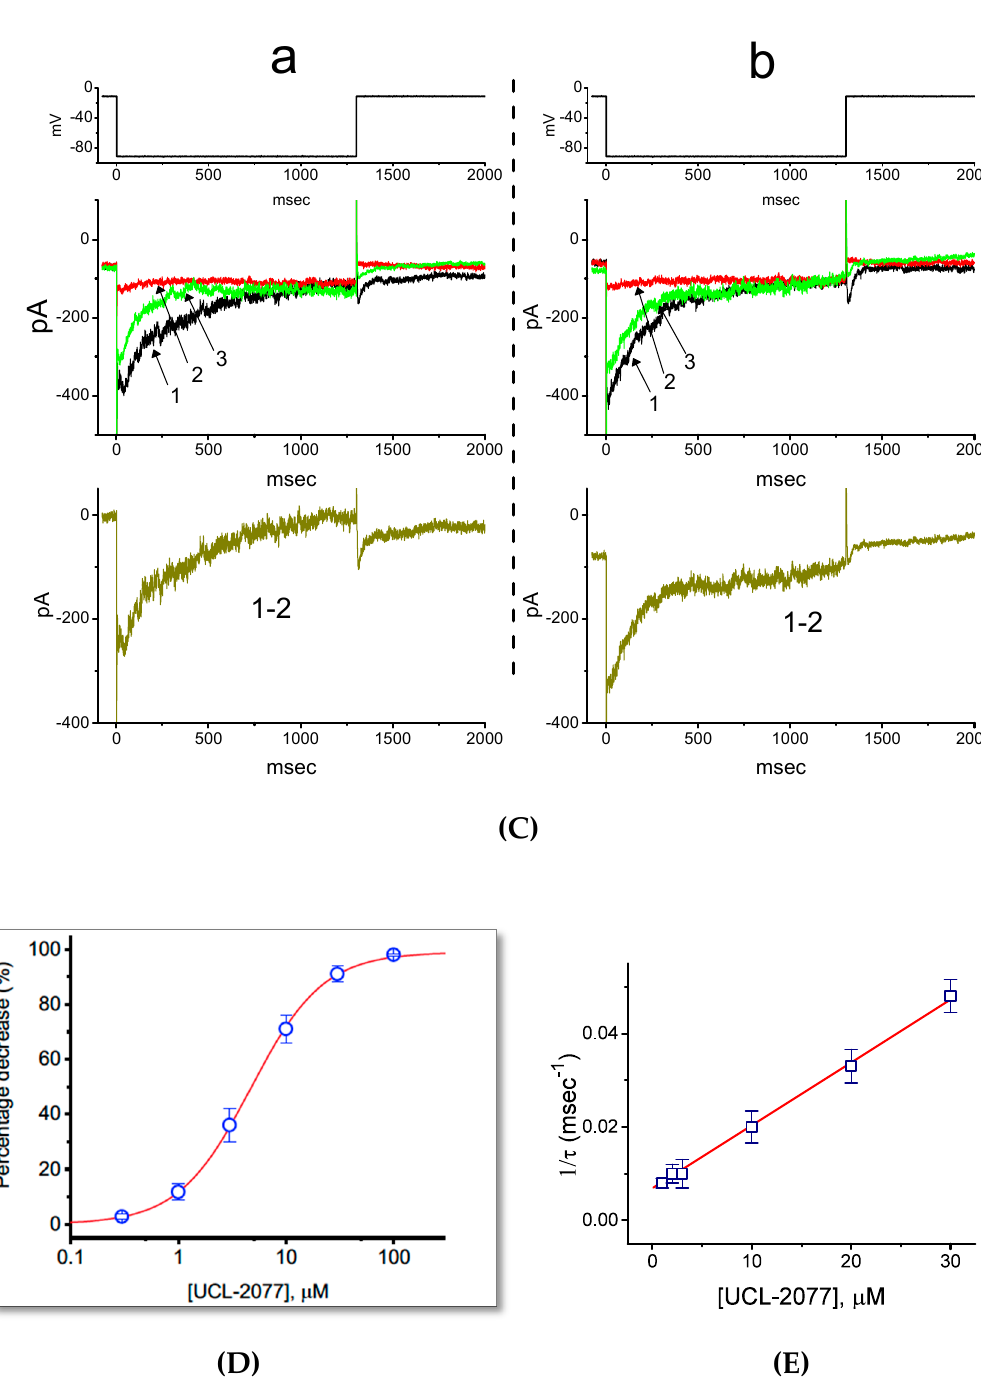
Figure 1. E ff ect of UCL-2077 on hyperpolarization-elicited I K(erg) from pituitary tumor (GH 3 ) cells. In these experiments, we bathed cells in a high-K + , Ca 2 + -free solution and we filled the recording pipette with K + -containing solution. ( A ) Representative current traces obtained in the control (a) and during cell exposure to 1 (b), 3 (c), 10 (d) or 100 µ M (e) of UCL-2077. The upper part is the voltage protocol used for the elicitation of I K(erg) , while the arrowhead indicates the zero-current level. ( B ) I K(erg) traces obtained in the control (a) and during exposure to 3 µ M azimilide (b) or 10 µ M aximilide (c). ( C ) I K(erg) traces (upper part) obtained in the control (a1 and b1), during exposure to 10 µ M azimilide (a2) or 10 µ M E-4031 (b2), or after washout of each agent (a3 and b3), respectively. The lower panel indicates the azimilide- or E-4031-sensitive component (i.e., a1 − a2 or b1 − b2) of I K(erg) , respectively. The